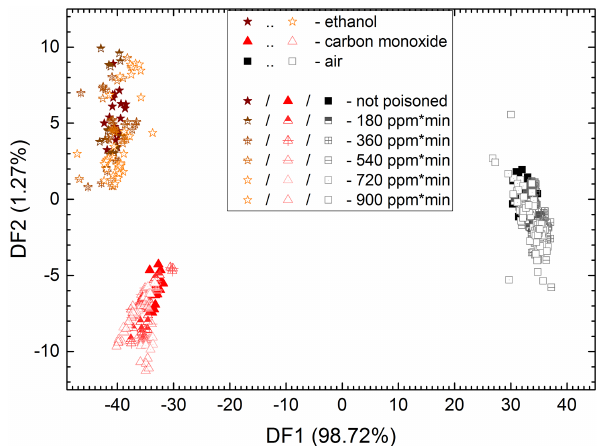
Figure 7. Temperature cycle for robust gas measurement and corre- sponding normalized conductance profiles for 5ppm ethanol, 5ppm carbon monoxide and pure air, respectively, all at 40%RH and for different poisoning states. The six areas shaded in gray with dura- tions of 1s for the three sections at 450 ◦ C and 5s for the three sec- tions at lower temperatures indicate the sections of the cycle from which features (mean value and slope) were extracted for the sub- sequent gas discrimination LDA.